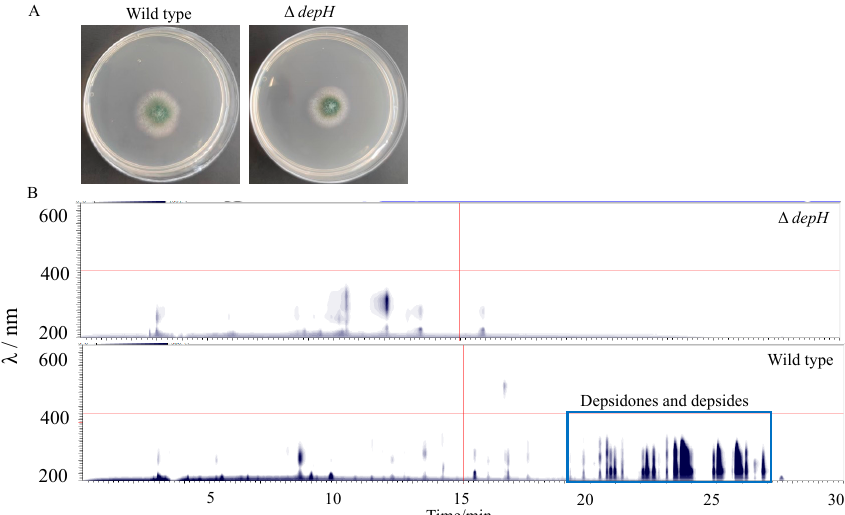
Figure 3. Characterization of the Δ depH mutant of Aspergillus sp. SCSIO SX7S7. ( A ) Growth of the wild ‐ type and Δ depH mutation strains on PDA plates at 28 °C for 4 days. ( B ) HPLC ‐ DAD contour plot of extracts from the wild ‐ type and Δ depH mutation strains. The boxed region shows DEPs.